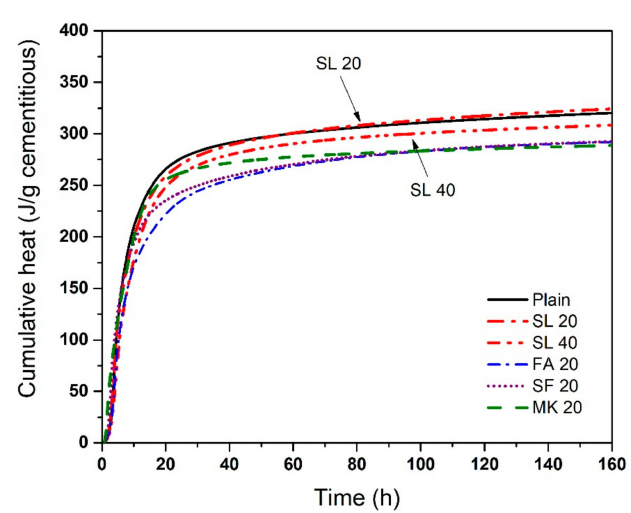
Figure 8. Cumulative heat release of cement paste with various SCMs at 50 ◦ C. The difference in the cumulative heat of repeat specimens was generally